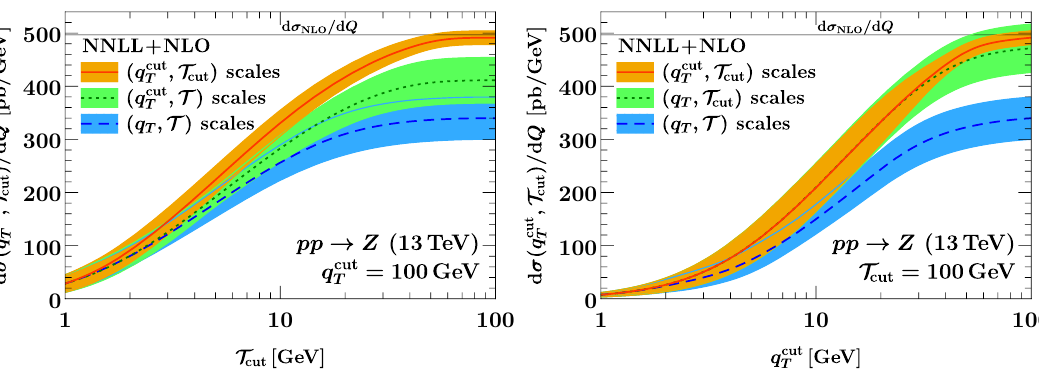
Figure 11 . The double cumulant cross section as a function of T cut for q cut a function of q cut for T cut = 100 GeV (right). The bands indicate the total perturbative uncertainty T (cid:1) total , see section 3.4. The colors correspond to di(cid:11)erent scale setting prescriptions (default: solid orange); see the text for